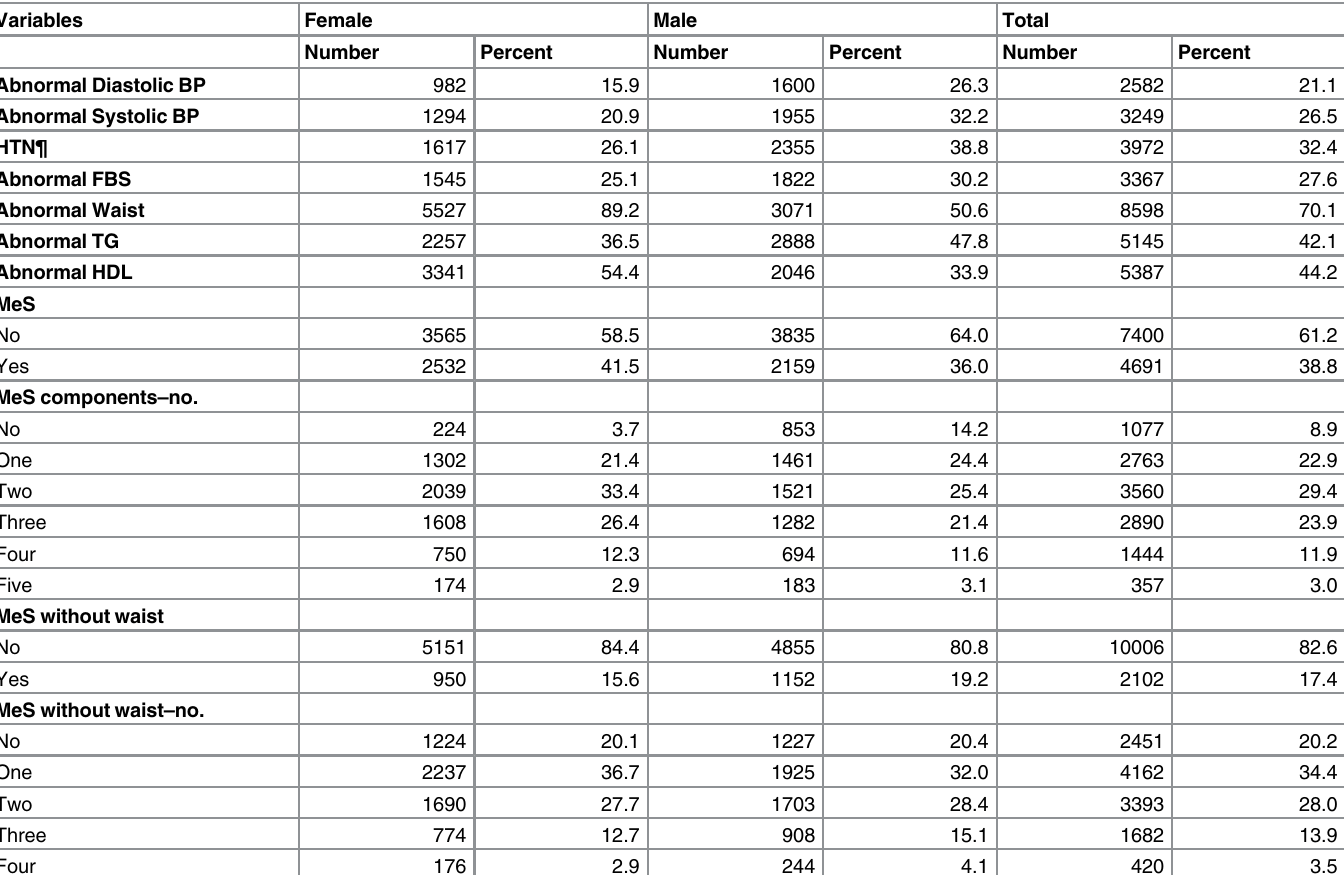
Table 2. Abnormal findings of the study population based on the definition of metabolic syndrome *